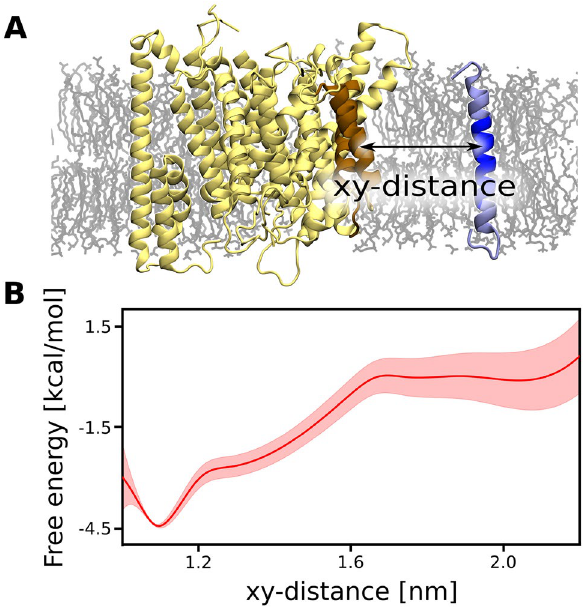
Figure 2. ( A ) Structural representation of the reaction coordinate used for our free energy simulations, i.e., center-of-mass distance projected on a membrane plane ( xy -distance) between TM6 and TM9 of presenilin and TM of β -CTF. ( B ) The free energy profile for the substrate binding to the exosite of γ -secretase formed by presenilin TM6 and